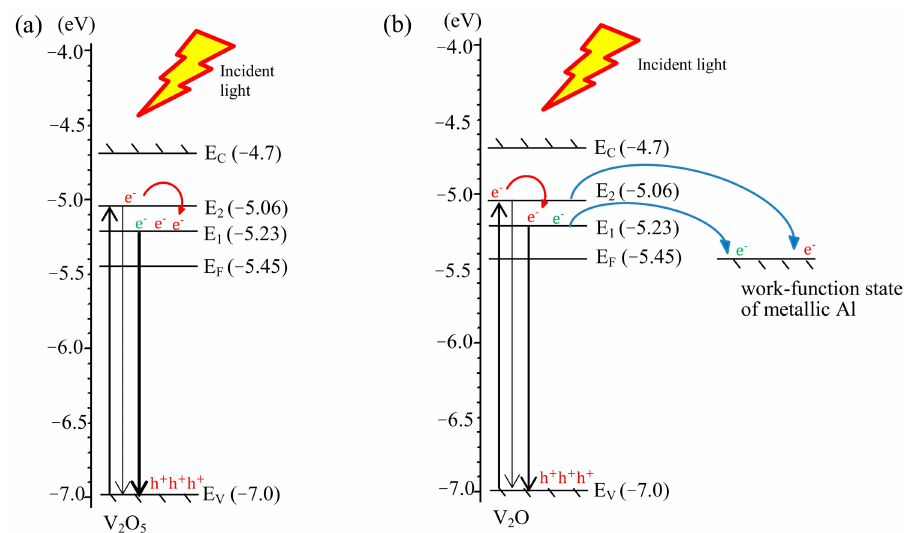
Figure 6. Proposed mechanism of the migration pathways for the electrons and holes in ( a ) Al-free and ( b ) Al-doped V 2 O 5 NSs at an equilibrium